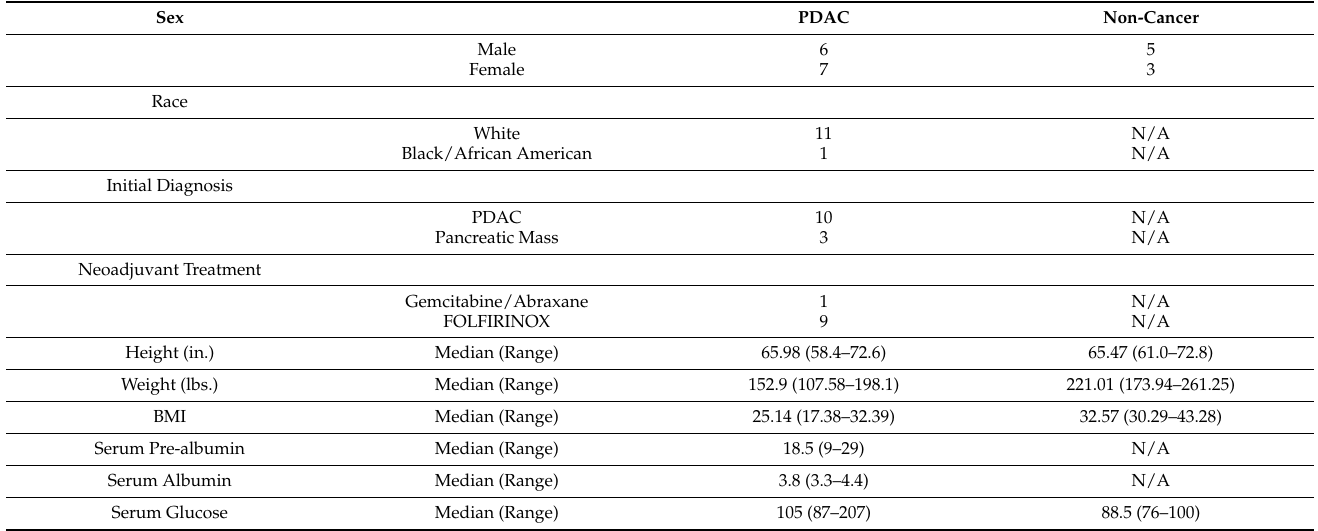
Table 1. PBMC Donor Demographic Information. The demographic information for PDAC and non-cancer